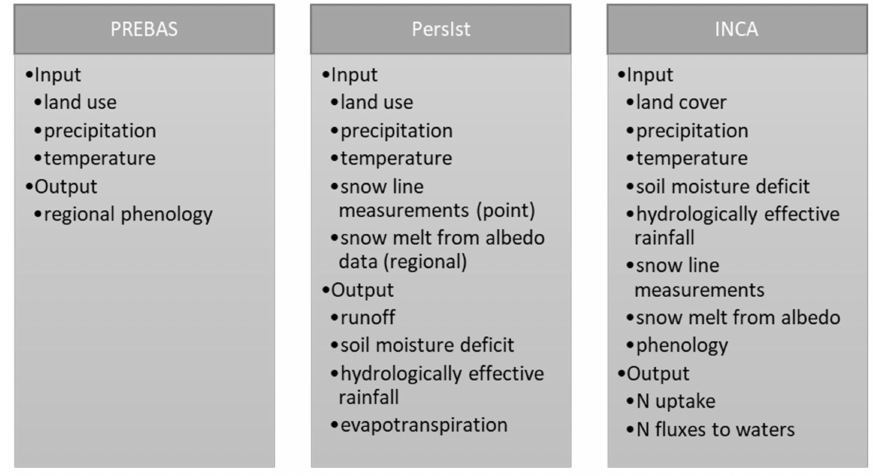
Figure 4. Data flow between the ecosystem